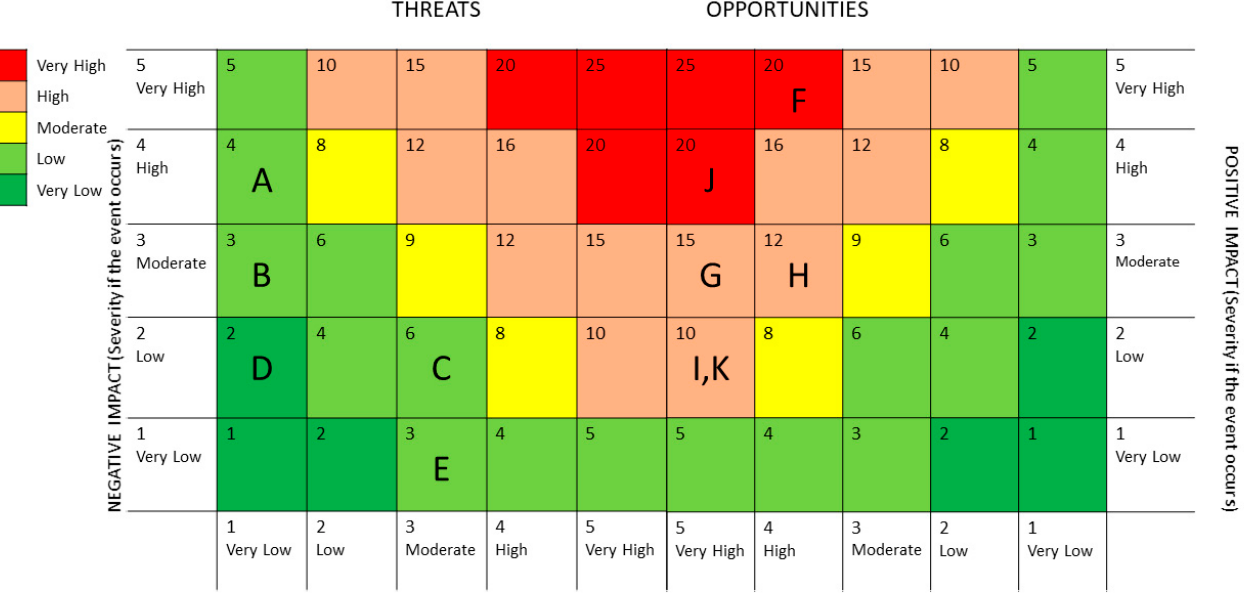
Figure 4. Tool for qualitative risk assessment: probability and impact matrix. Source: Authors.